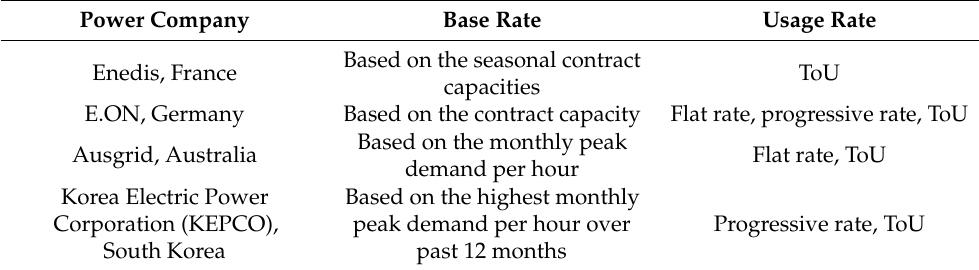
Table 1. The characteristics of the retail billing plans of the power companies in each country. Power Company